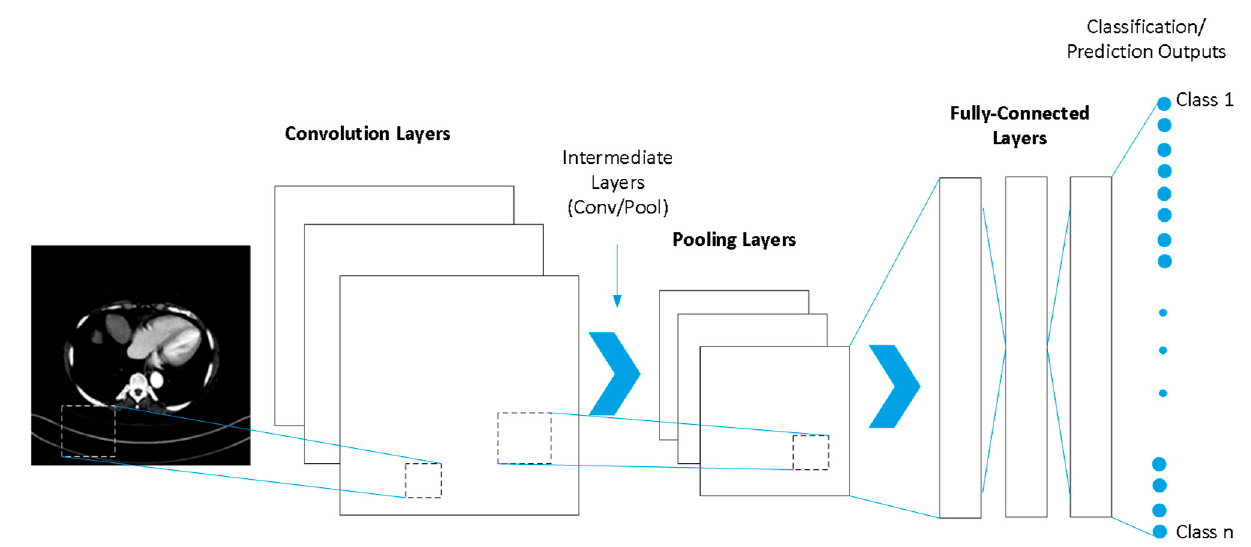
Figure 1. Components of a CNN deep learning network.